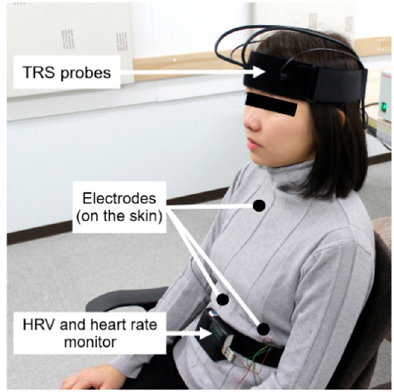
Figure 4. Assessment of physiological indicators .